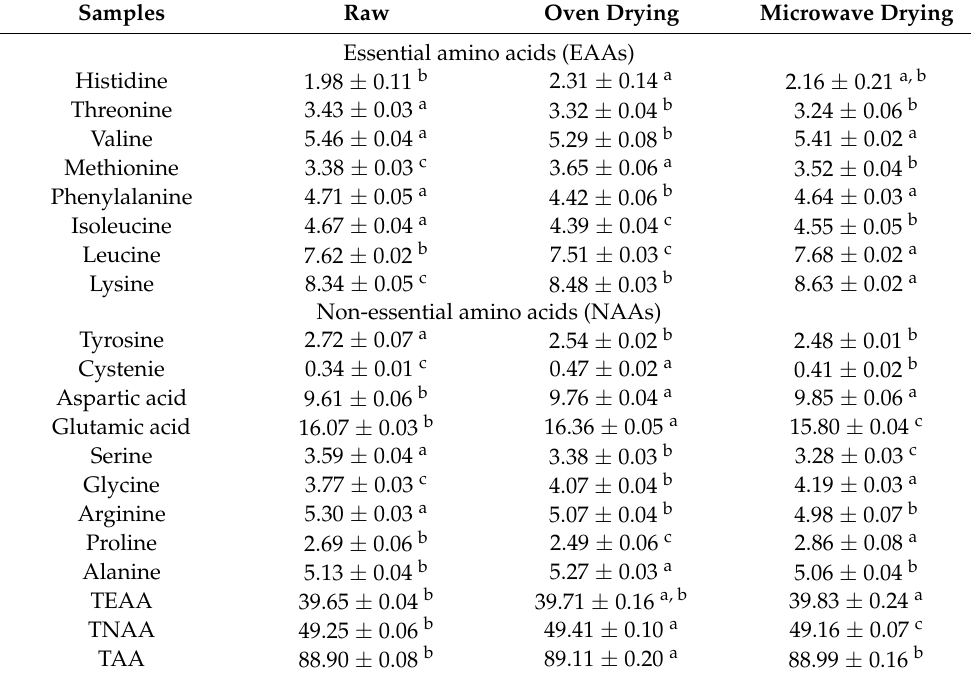
Table 2. Amino acid compositions of raw, oven, and microwave drying of bighead carp H. nobilis fillets.